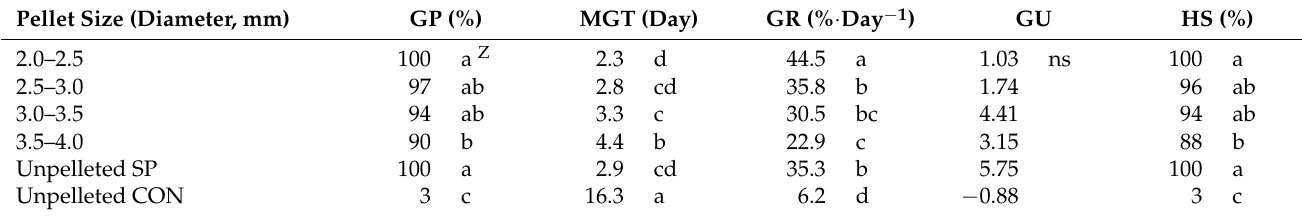
Table 2. Effect of pelleting and size of pelleted seeds on germination percentage (GP), mean ger- mination time (MGT), germination rate (GR), germination uniformity (GU), and healthy seedling percentage (HS) of A. sikokianus seeds.